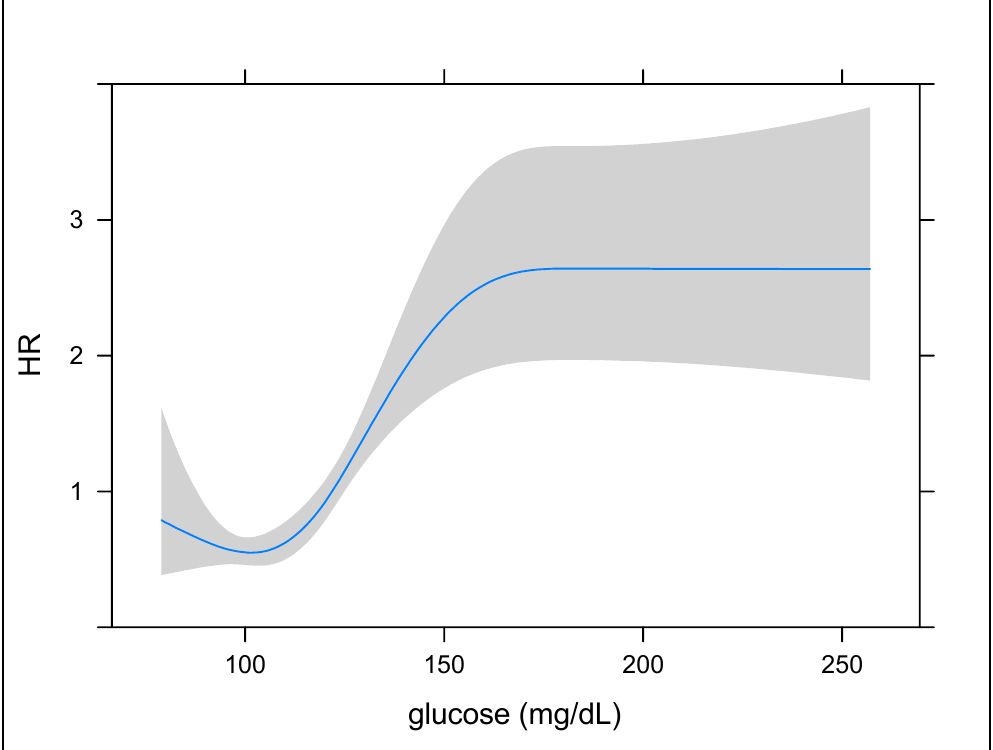
Figure 2. The restricted cubic splines demonstrating the nonlinear relationship between hyperglycemia and in-hospital mortality. The shaded areas around the curves describe the 95% confidence interval.